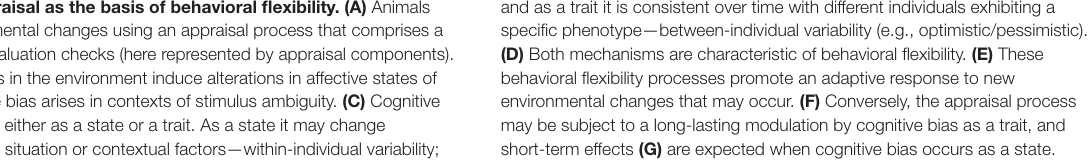
FIGURE 1 | Appraisal as the basis of behavioral flexibility. (A) Animals evaluate environmental changes using an appraisal process that comprises a set of stimulus evaluation checks (here represented by appraisal components). (B) Once changes in the environment induce alterations in affective states of animals, cognitive bias arises in contexts of stimulus ambiguity. (C) Cognitive bias may be seen either as a state or a trait. As a state it may change depending on the situation or contextual factors—within-individual variability;